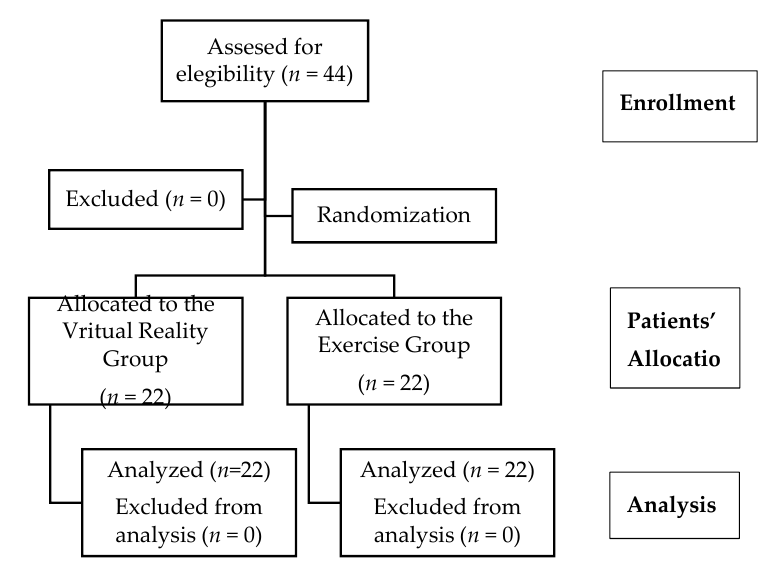
Figure 4. Recruitment flow diagram. Table 1. Demographic and baseline characteristics from each group.